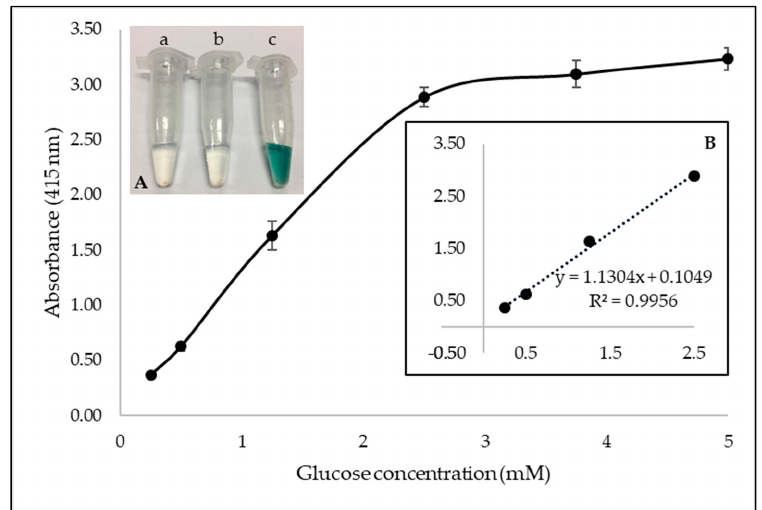
Figure 5. Dose-dependent curve of glucose detection using GOx-magnetic CNCs. (Inset A showing reactions ( a ) without HRP, ( b ), control and ( c ) with 25 mM glucose; Inset B showing the linear range of glucose detection).